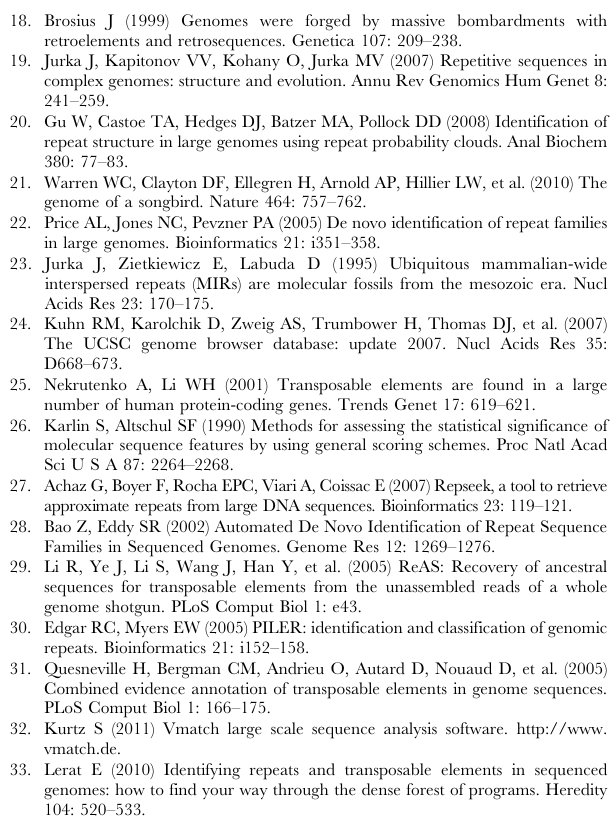
Figure S1 Interpolation of percent MIR fragments successfully identified using spline regression. Figure S2 The relation between copy number and number of oligos. The number of 16-mer oligos not included in P-clouds (circles, solid line) and the number expected based on Poisson expectation (squares, dashed line) are shown. The data shown is for a P -clouds analysis with parameter setting C 10 . (PDF) Table S1 P -clouds parameter settings and estimated false positive rates for complete mammalian genomes [20]. (XLSX) Table S2 The genomic location and classification of the randomly selected 1,000 human Alu elements. Table S3 The genomic location and classification of the randomly selected 1,000 human MIR elements. Table S4 Summary of false positive estimates for Alu ESP s. (XLSX) Table S5 Summary of false positive estimates for MIR ESP s. (XLSX) Table S6 Summary of de novo P-clouds analysis of the entire human genome, with length-dependent false positive estimates and expected true positives.